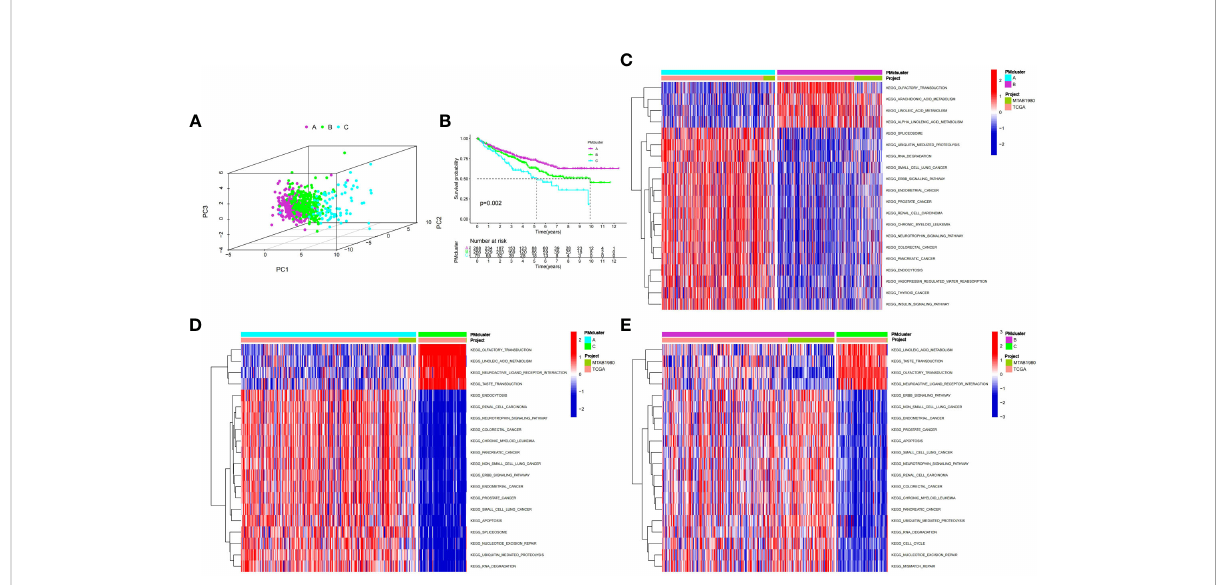
FIGURE 2 Identi fi cation and biological characteristics of PMRG expression cluster. (A) Three-dimensional PCA showed the difference of PMRG expression i clusters A, B and C. (B) Kaplan – Meier curves of survival differences among the three PMRG expression clusters. (C – E) Biological pathways enriched among different PMRG expression clusters. PMRG, polyamine metabolism-related